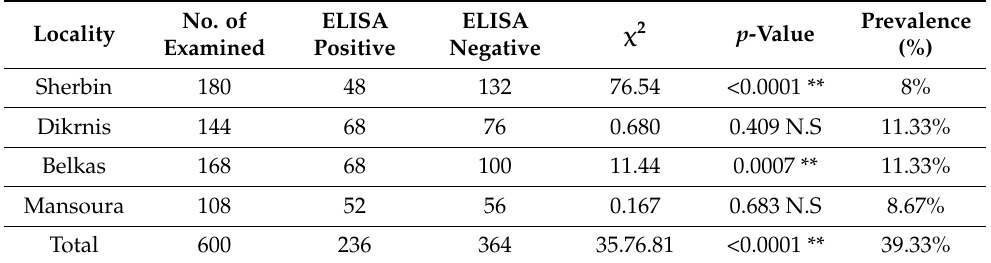
Table 2. Prevalence of leptospirosis in cattle according to